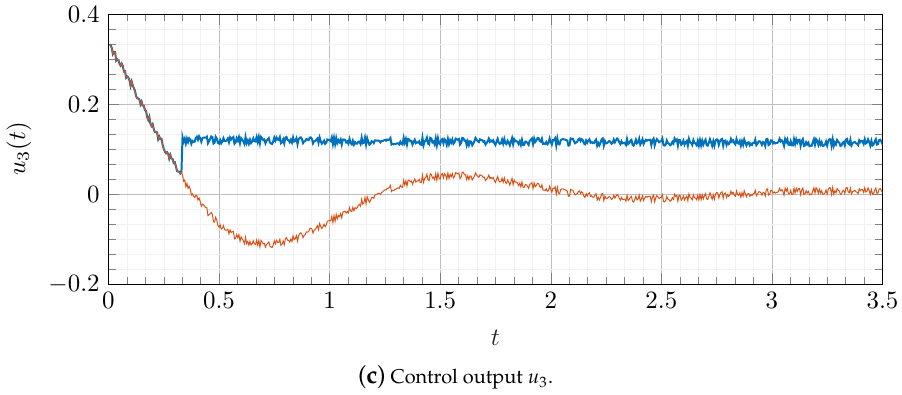
Figure 6. Controller outputs for the reference tracking example: (orange) base PI controllers; (blue) PI + CI controllers.